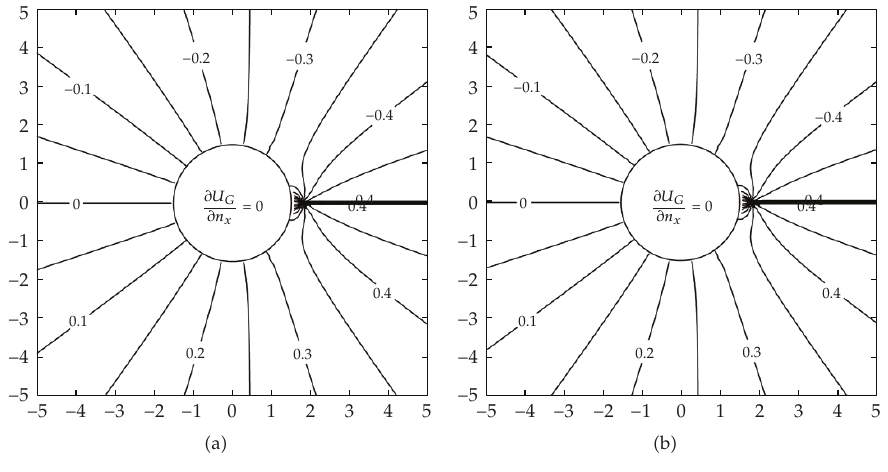
Figure 8: Displacement contour (cid:5) Neumann boundary condition (cid:6) by using (cid:5) a (cid:6) the Smith’s method (cid:2) 1 (cid:3) and (cid:5) b (cid:6) the present method (cid:5) M (cid:4) 50 (cid:6)